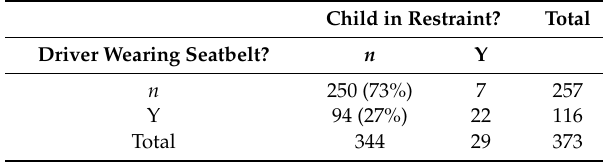
Table 3. Child restraint use compared to driver seatbelt